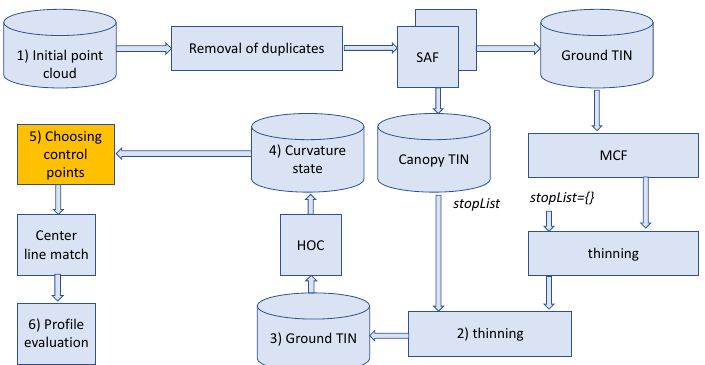
Figure 3. The process chart of the computational steps (1)–(6), which are detailed later in the text. SAF is used twice to produce two TIN models. The thinning is done first to all ground points with no limitation, then to that part of the remaining canopy front points, which are overlapping the canopy points. HOC produces a curvature state, which is visualized in order to choose manual control points. The control points are inserted manually, and this phase has potential for further automation (orange box). The end product is the rut depth profile distribution.